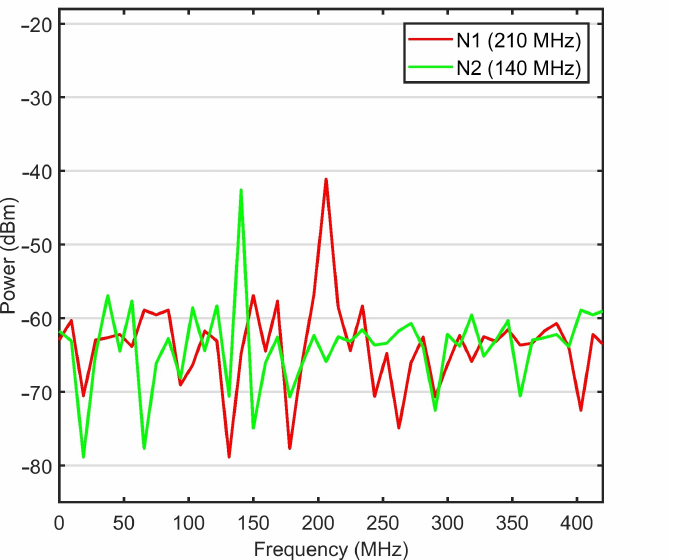
Figure 5. Example of received RF signal from sensing nodes N1 and N2 after 3.2 km transmitted in WON with moderate